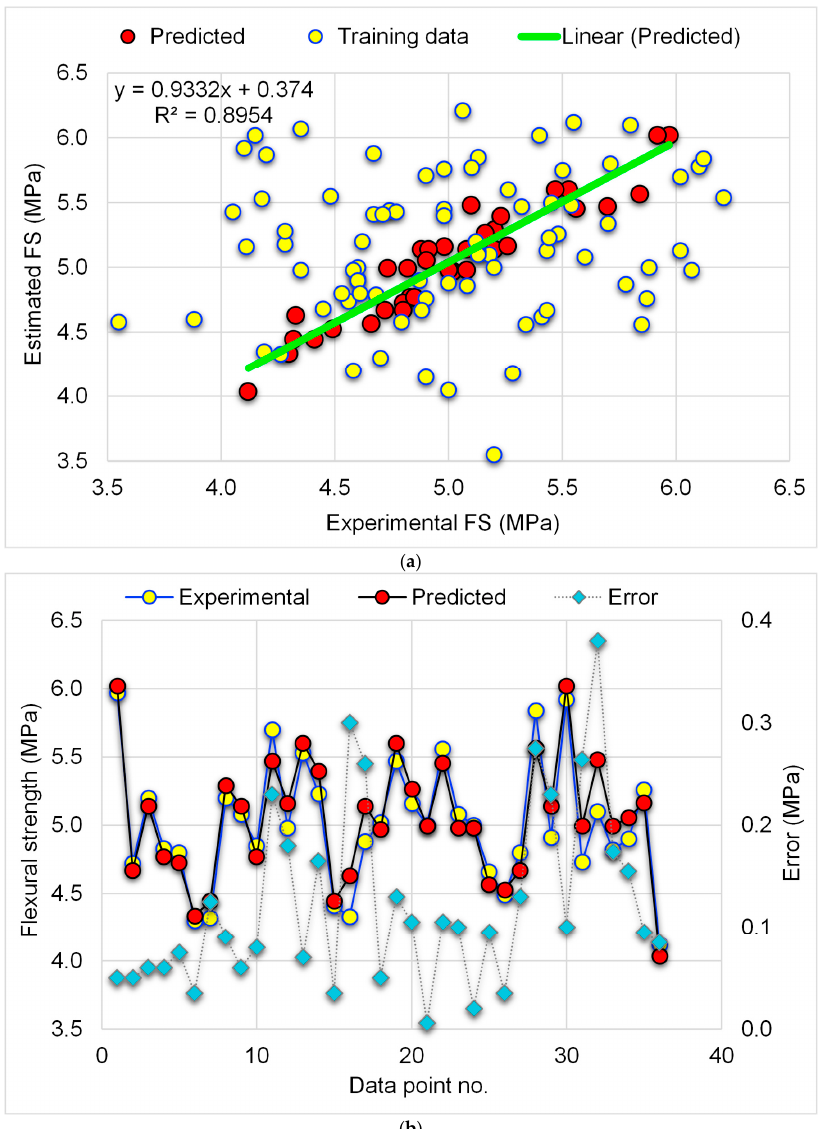
Figure 9. GBR-FS model: ( a ) correlation amongst experimental and predicted FS; ( b ) distribution of experimental and predicted FS and error values.